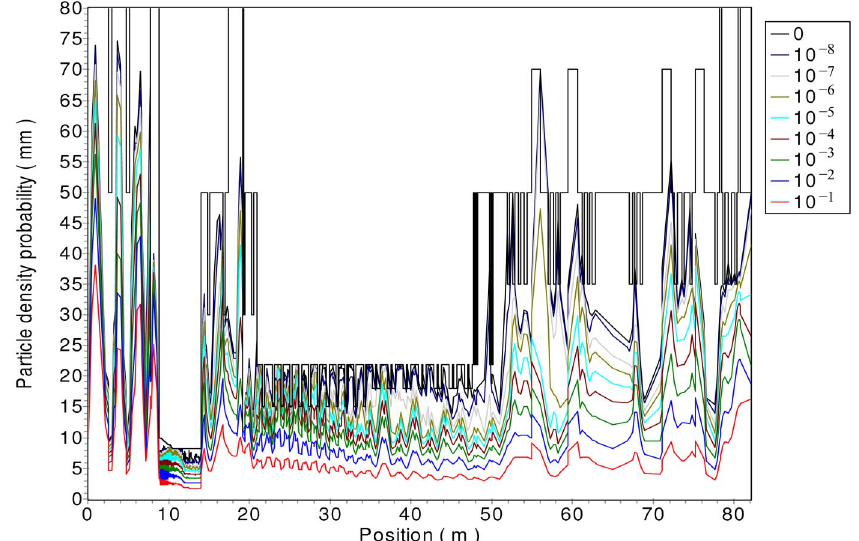
FIG. 19. (Color) Beam size radii along the linac. 10 (cid:3) 1 corresponds to 90% and the last black one is the aperture.